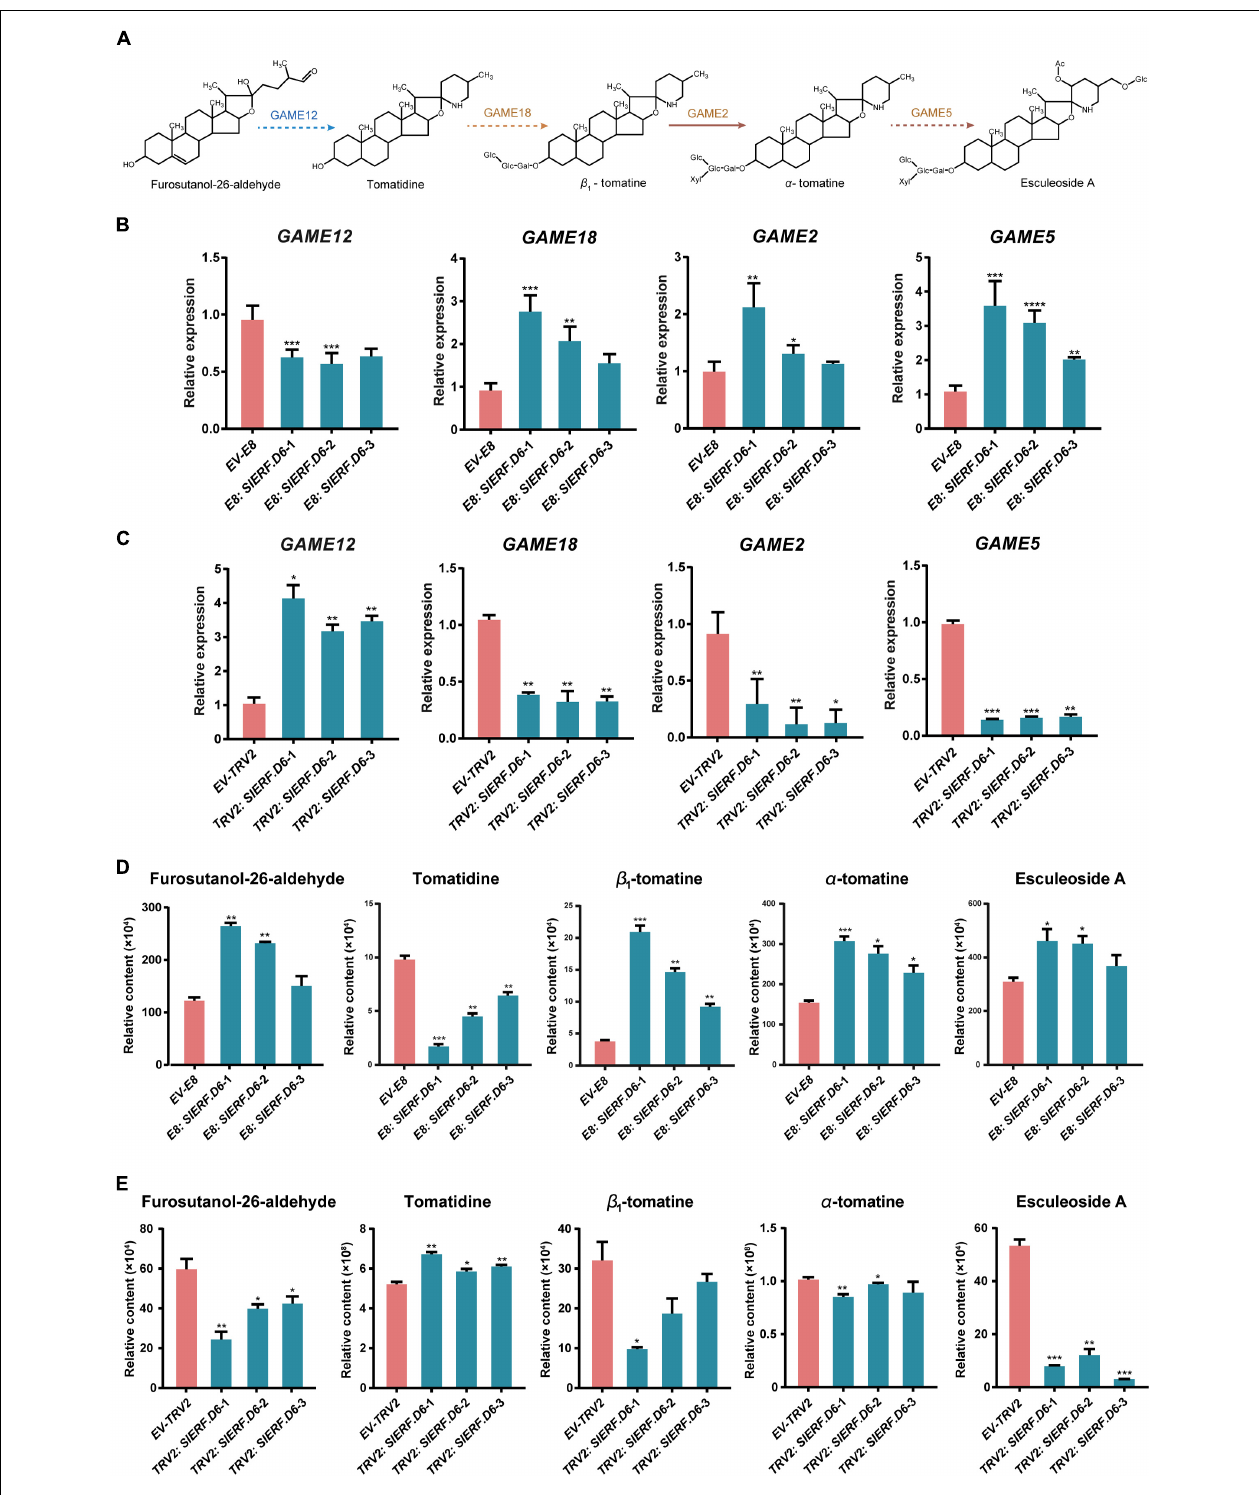
FIGURE 5 | SlERF.D6 influences the content of SGAs in tomato fruit. (A) Schematic representation of SGAs biosynthesis and regulation in tomato. (B) Expression level of some SGAs pathway genes in E8: SlERF.D6 lines. X -axis represents different lines and the Y -axis represents relative expression. (C) The expression level of some SGAs pathway genes in TRV2: SlERF.D6 lines. X -axis represents different lines and the Y -axis represents relative expression. (D) The contents of some related metabolites in E8: SlERF.D6 lines. The Y -axis represents relative content. (E) The contents of some related metabolites in TRV2: SlERF.D6 lines. The Y -axis represents relative content. All the above error bars represent the SD ( n = 3) (* p < 0.05, ** p < 0.01, *** p < 0.001, **** p < 0.0001; Student’s t -test).